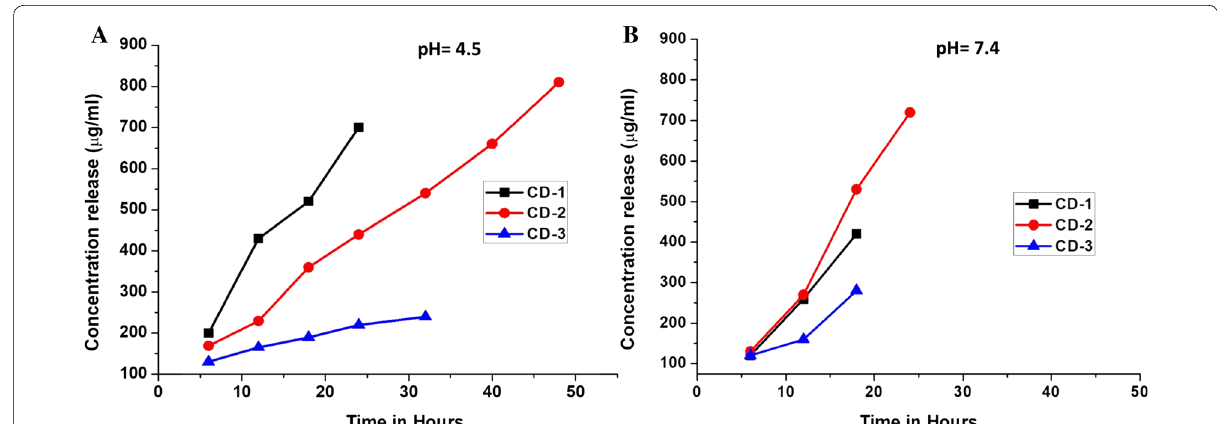
Fig. 5 in vitro release of drugs: 5 a In pH 4.5; 5 b In pH 7.4. In the acidic pH mimicking tumor microenvironment, the ability to release higher amounts of drugs is seen for longer spell of time by CD‑3